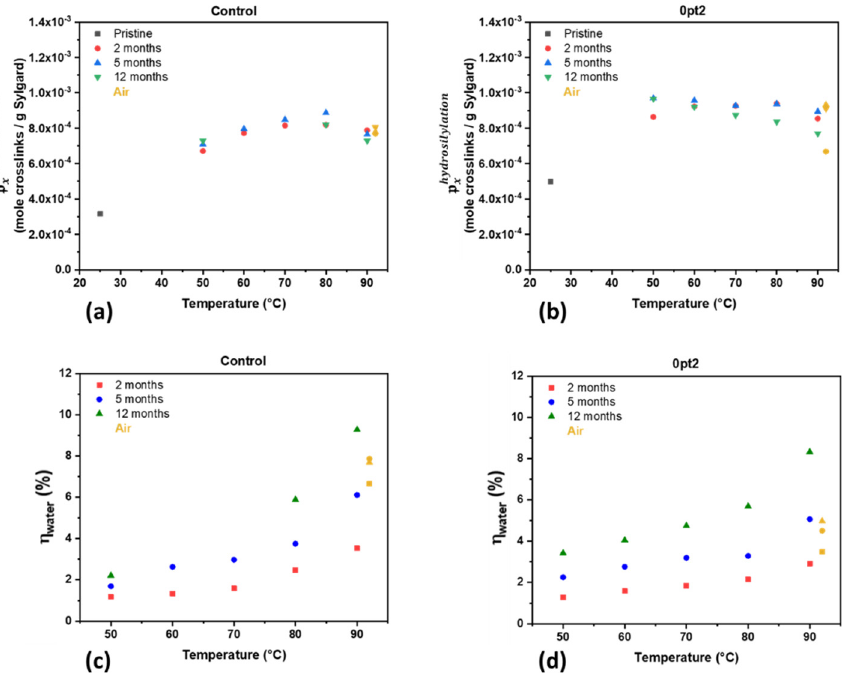
Figure 7. Specific crosslink density: ( a ) Crosslinks due to hydrosilylation for Controls; ( b ) Crosslinks due to hydrosilylation for 0pt2; ( c ) Water fraction for Controls; and ( d ) Water fraction for 0pt2.